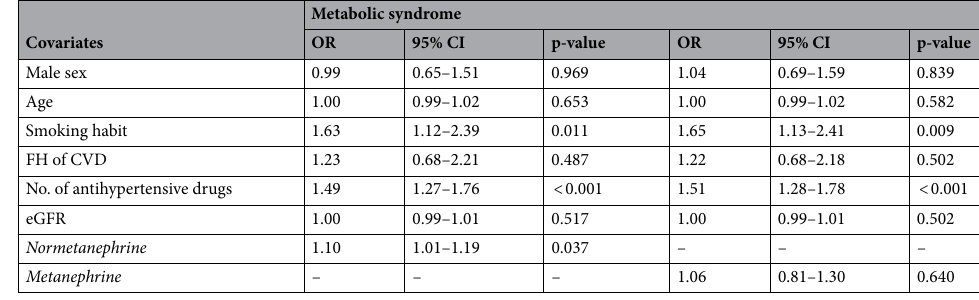
Table 5. Logistic regression analysis on the association of metanephrines and covariates with presence of metabolic syndrome (ORs of normetanephrine and metanephrine are calculated for a unit of increase of 100 μg/day). CI, confidence interval; CVD, cardiovascular disease; eGFR, estimated glomerular filtration rate; FH, family history; OR, odds ratio.